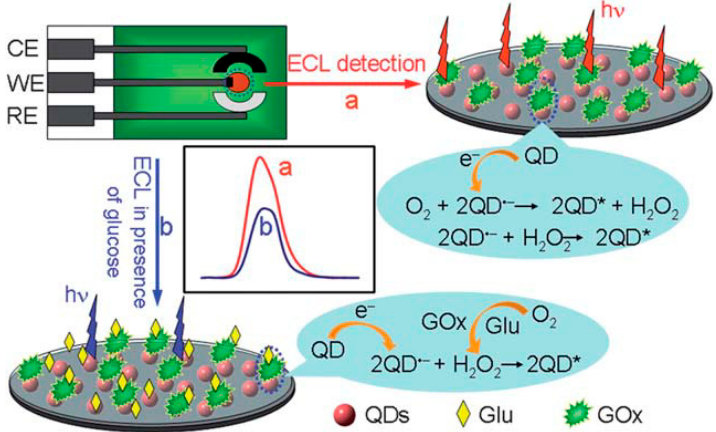
Figure 7. Schematic display of the ECL glucose biosensor developed by Cheng, L. et al. [108] employing bidentate-chelated CdTe QDs as emitters of ECL for glucose detection. Reproduced and adapted with permission of Royal Society of Chemistry.